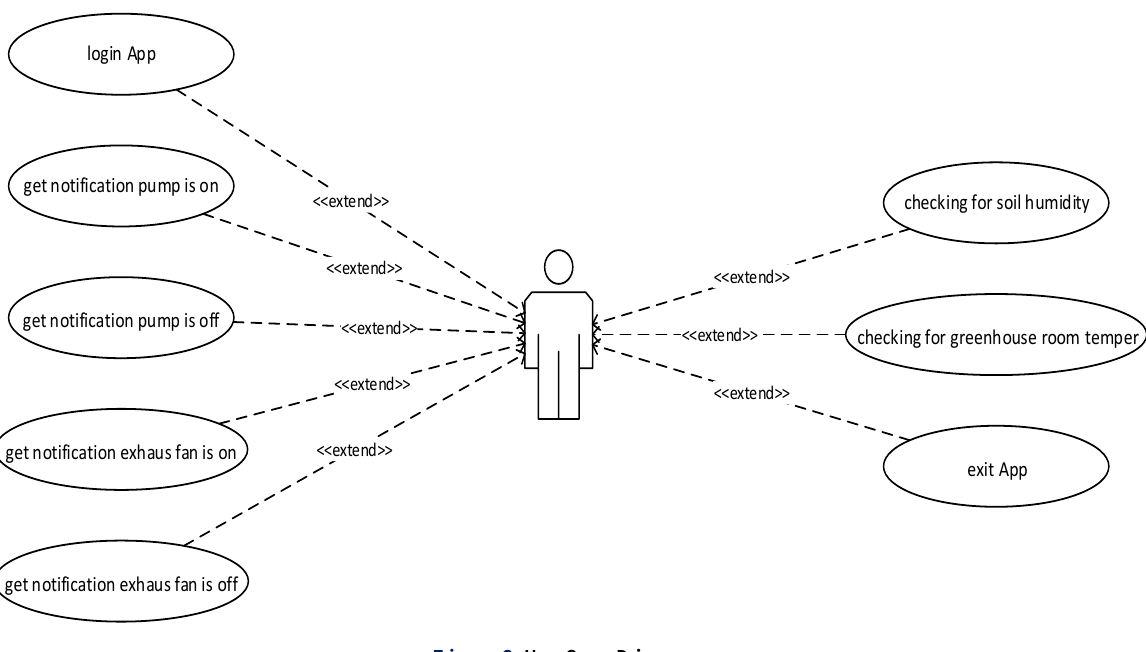
Figure 2. Use Case